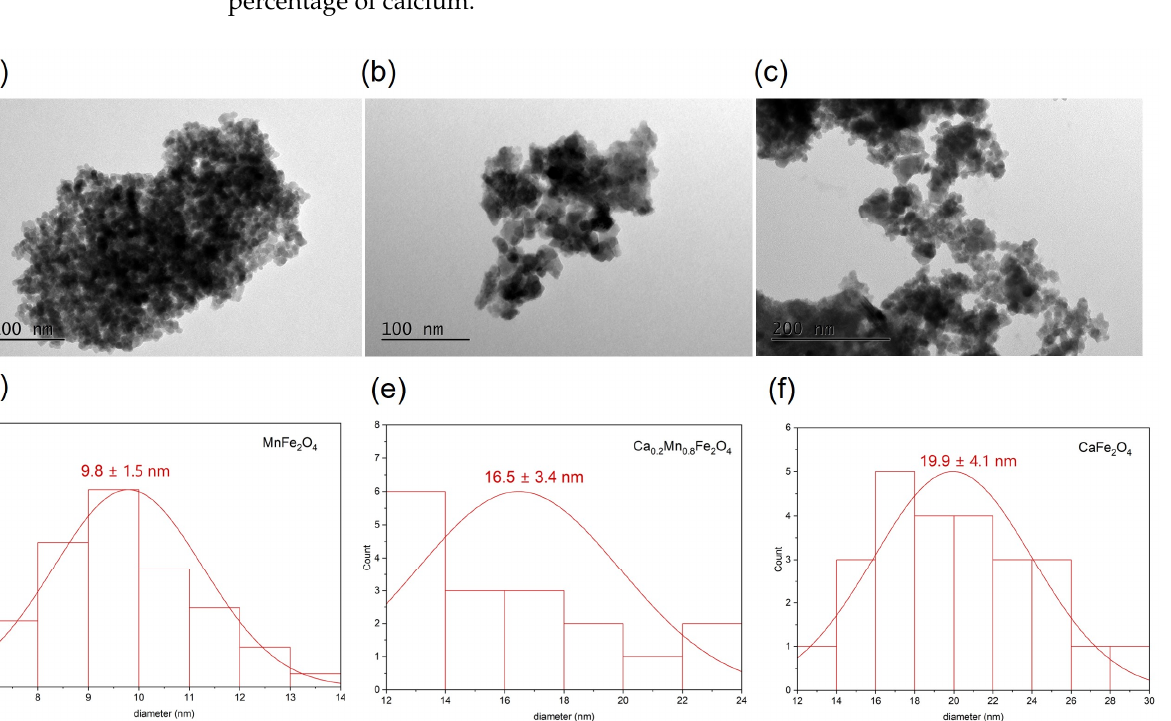
Figure 2. TEM images of MnFe 2 O 4 ( a ), Ca 0.2 Mn 0.8 Fe 2 O 4 ( b ) and CaFe 2 O 4 ( c ) NPs and corresponding histograms of size distribution ( d – f ).